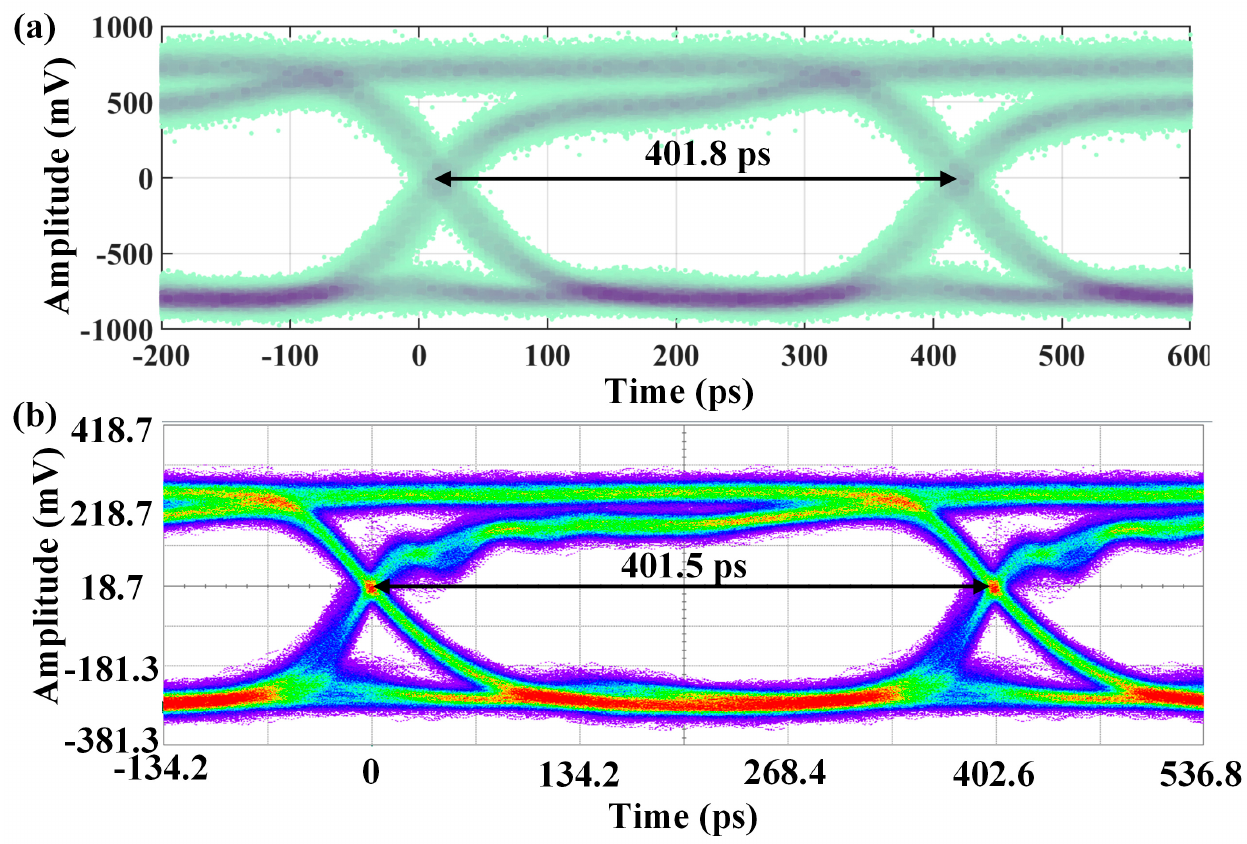
Figure 4. The eye diagrams measured by ( a ) the proposed time jitter analysis method, and ( b ) the commercial oscilloscope SDA 820Zi ‐ B.